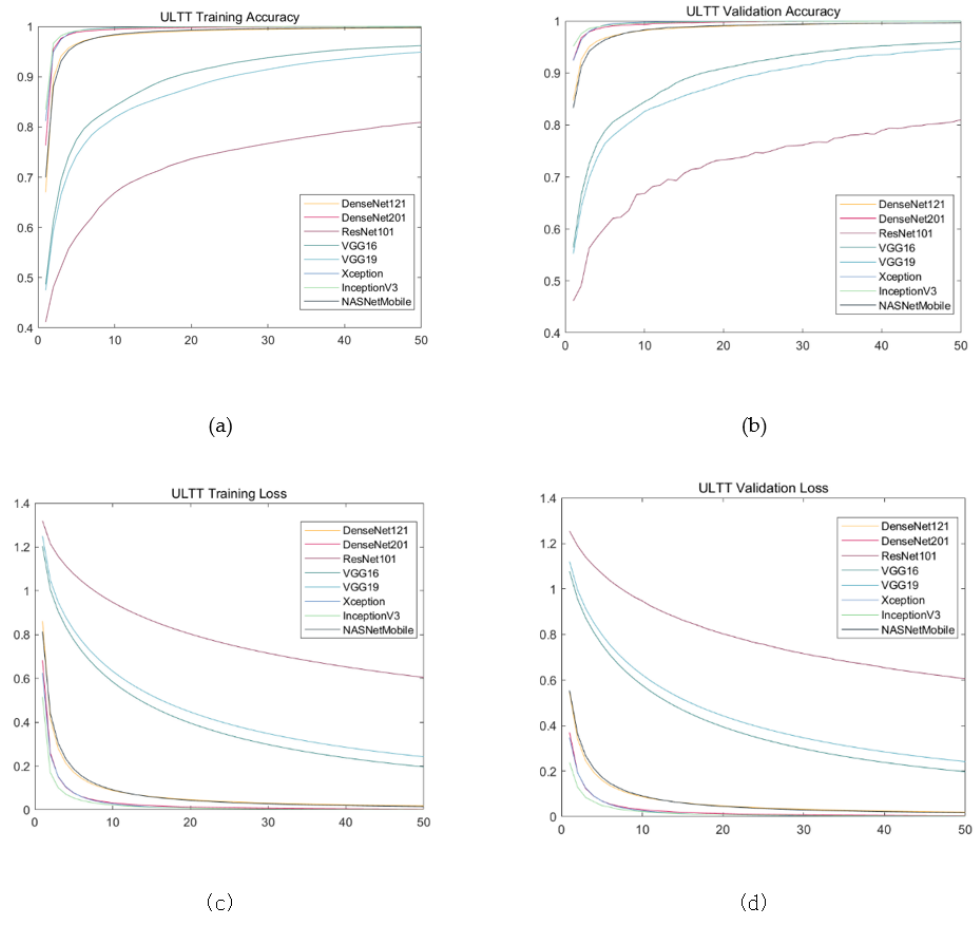
Figure 8. Training results on ULTT data set. ( a ) Training accuracy; ( b ) validation accuracy; ( c ) training loss; ( d ) validation loss.